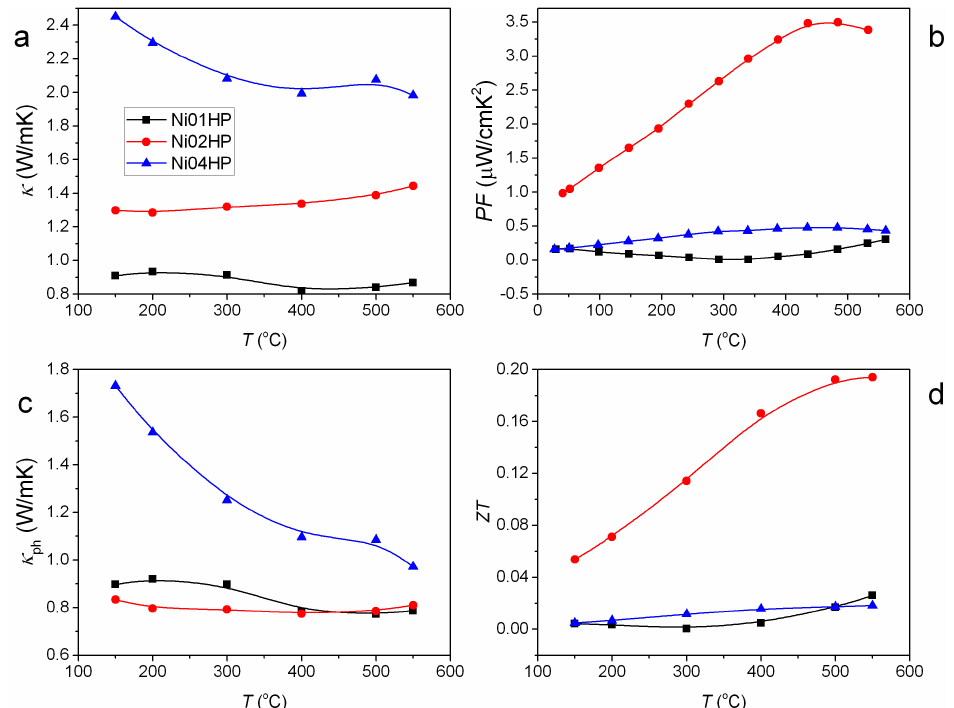
Figure 6. Temperature dependence of total thermal conductivity κ ( a ); power factor PF ( b ); lattice thermal conductivity (phonon contribution) κ ph ( c ); and ZT ( d ) for the series of hot pressed